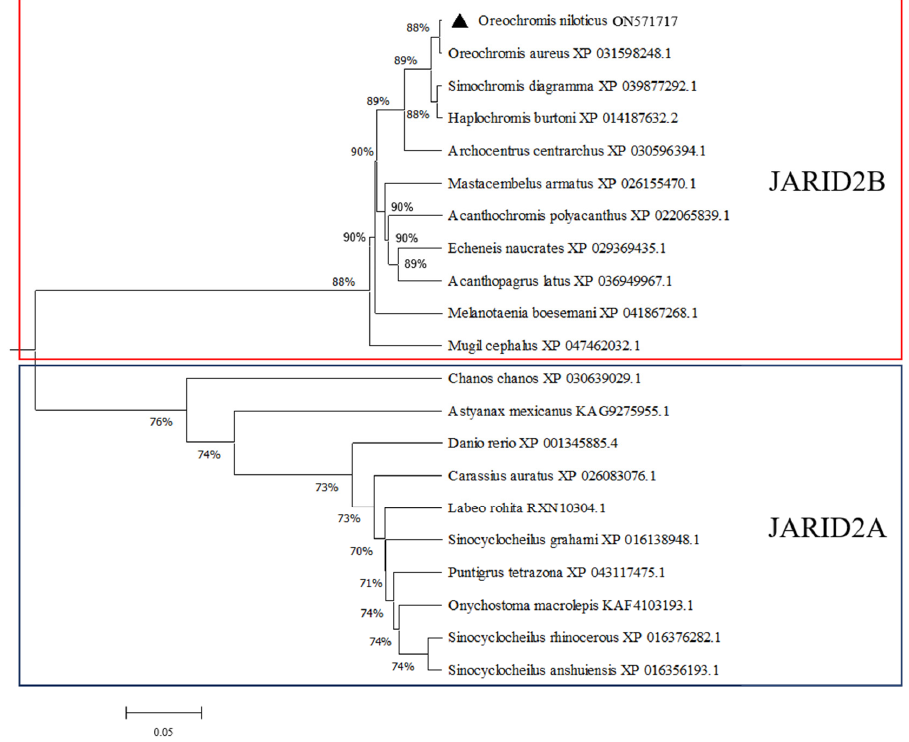
Figure 3. Phylogenetic analysis of JARID2B and JARID2A from different species. Protein sequence IDs are indicated behind the species name. Numbers at the branch of the phylogenetic tree stand for bootstrap. Nile tilapia Jarid2b is marked with a black triangle ( ▲ ).